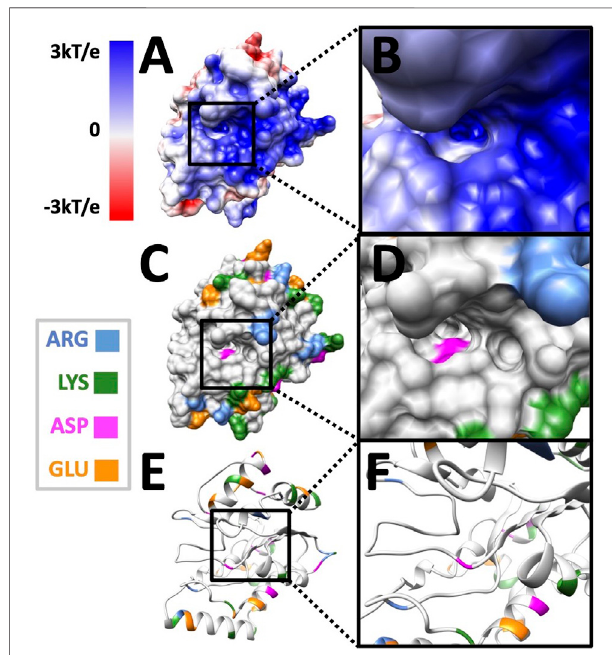
FIGURE 6 | The residue distributions on the surface of UDG. (A) The electrostatic potential on the surface of the UDG pocket side. (B) The electrostatic potential on the surface of the UDG binding interface area. (C) The surface of UDG with the colored charged residues as shown in the legend. (D) Thesurface ofthe UDGbindinginterface area. (E) Thestructure of UDG with the colored charged residues. (F) The structure of the UDG binding interface